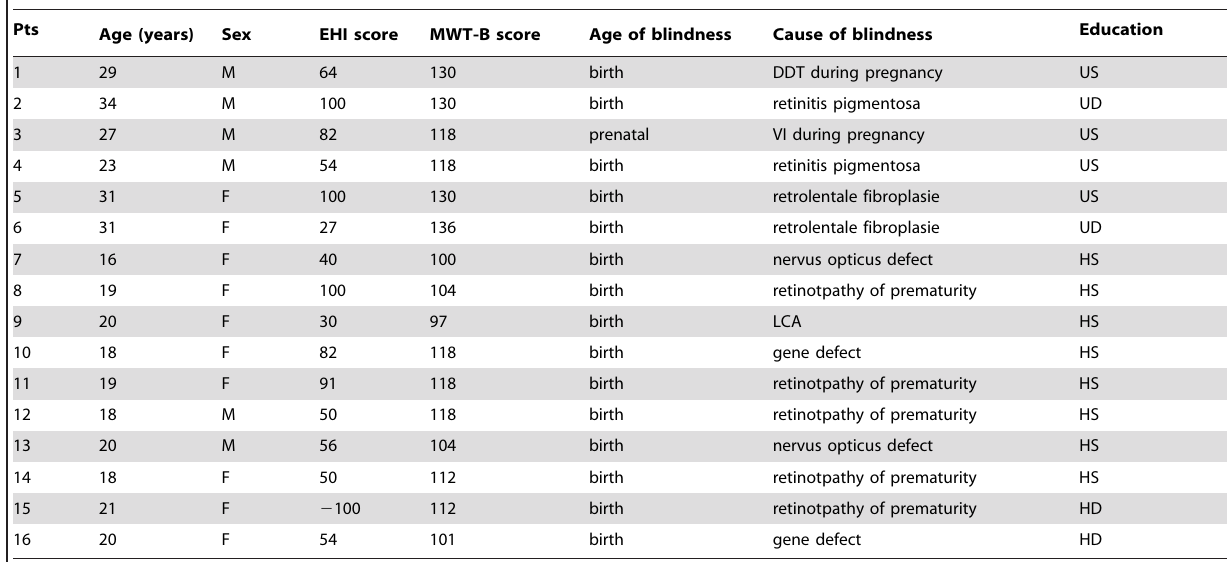
Table 1. Description of the congenitally-blind participants.